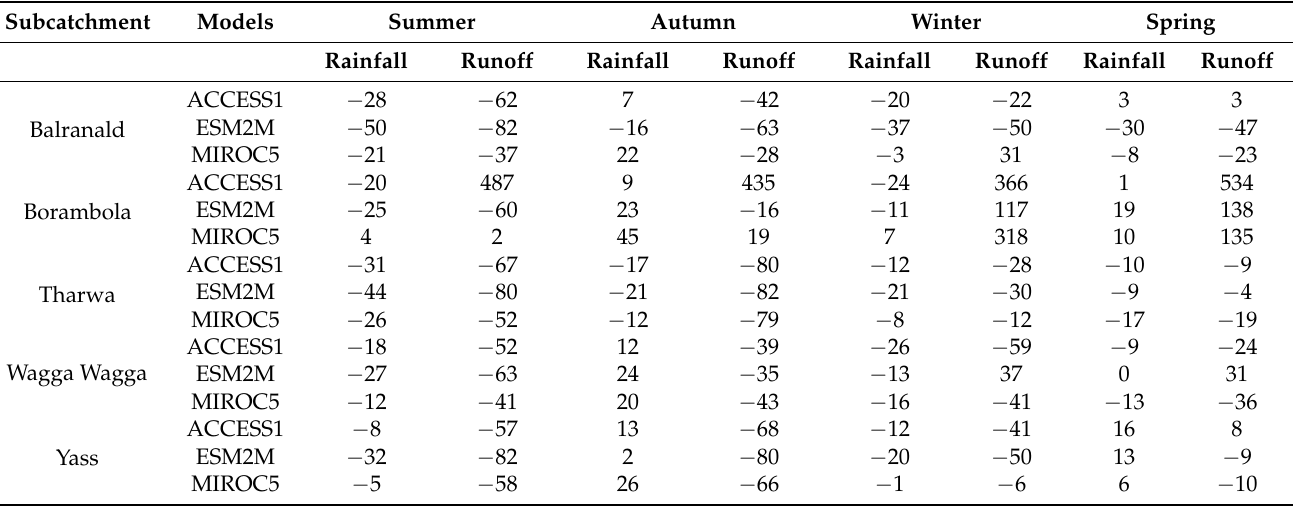
Table 7. Seasonal change (%) of rainfall and runoff for RCP 4.5 at sub-catchments of Murrumbidgee River basin.